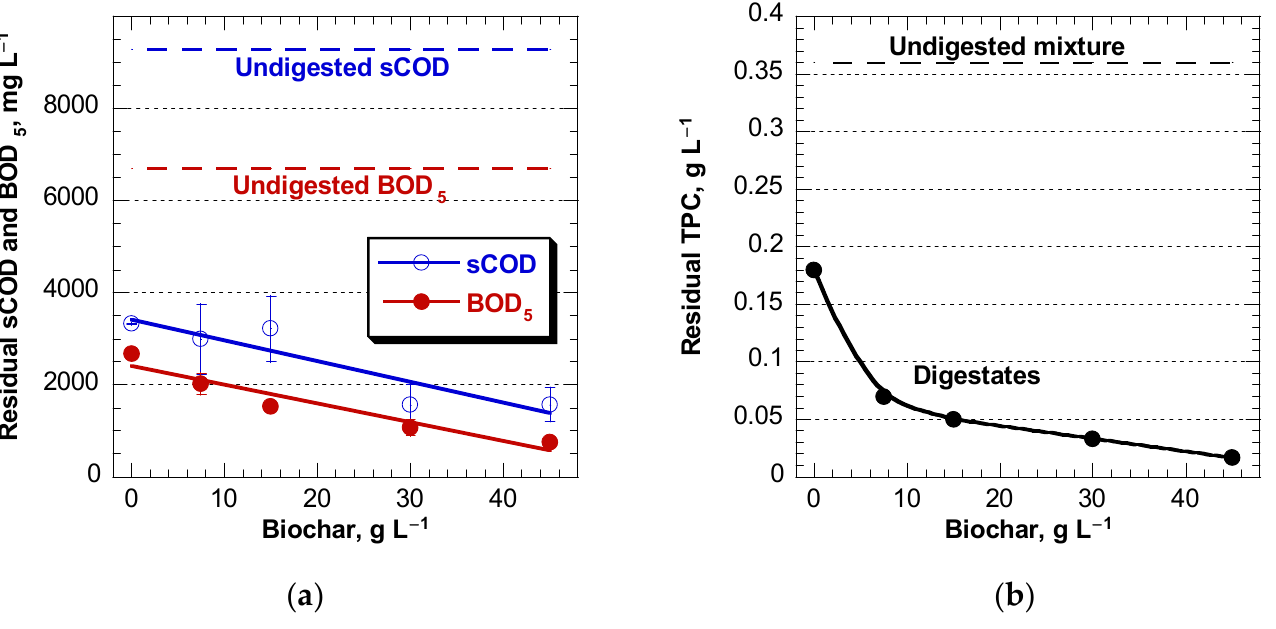
Figure 4. Residual sCOD and BOD 5 ( a ) and residual TPCs ( b ) of digestate soluble fraction from digesters with different biochar concentrations.